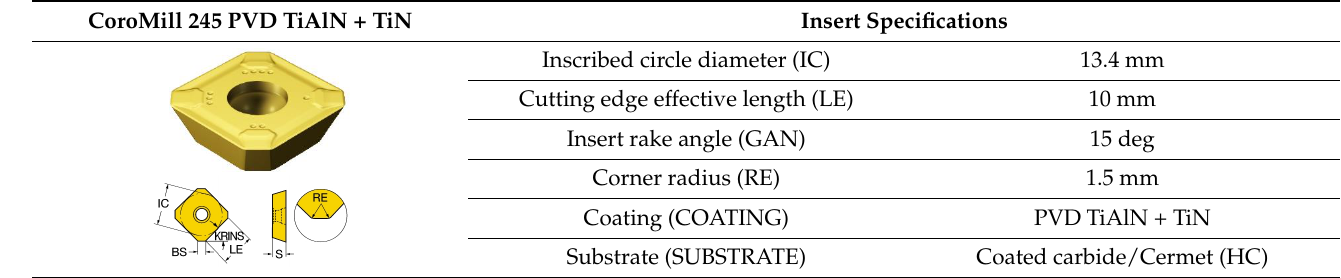
Figure 2. ( a ) Optical microscope and ( b ) Profilometer Mitutoyo SV-C4000. Tool wear was measured according to the ISO standard V B max as a common quanti- tative parameter. To measure V B max (Figure 3), the cutting tool worn-out length (b) was measured using a toolmaker optical microscope (Figure 2a) with a precise measurement of 0.005 mm. Then, near zone N (equal to b/4), the distance between the rake face and the end of the worn-out region, V B max , was measured. The arithmetical mean roughness value R a was used to characterize surface roughness (Figure 4). The smaller the R a , the smoother the machined surface.